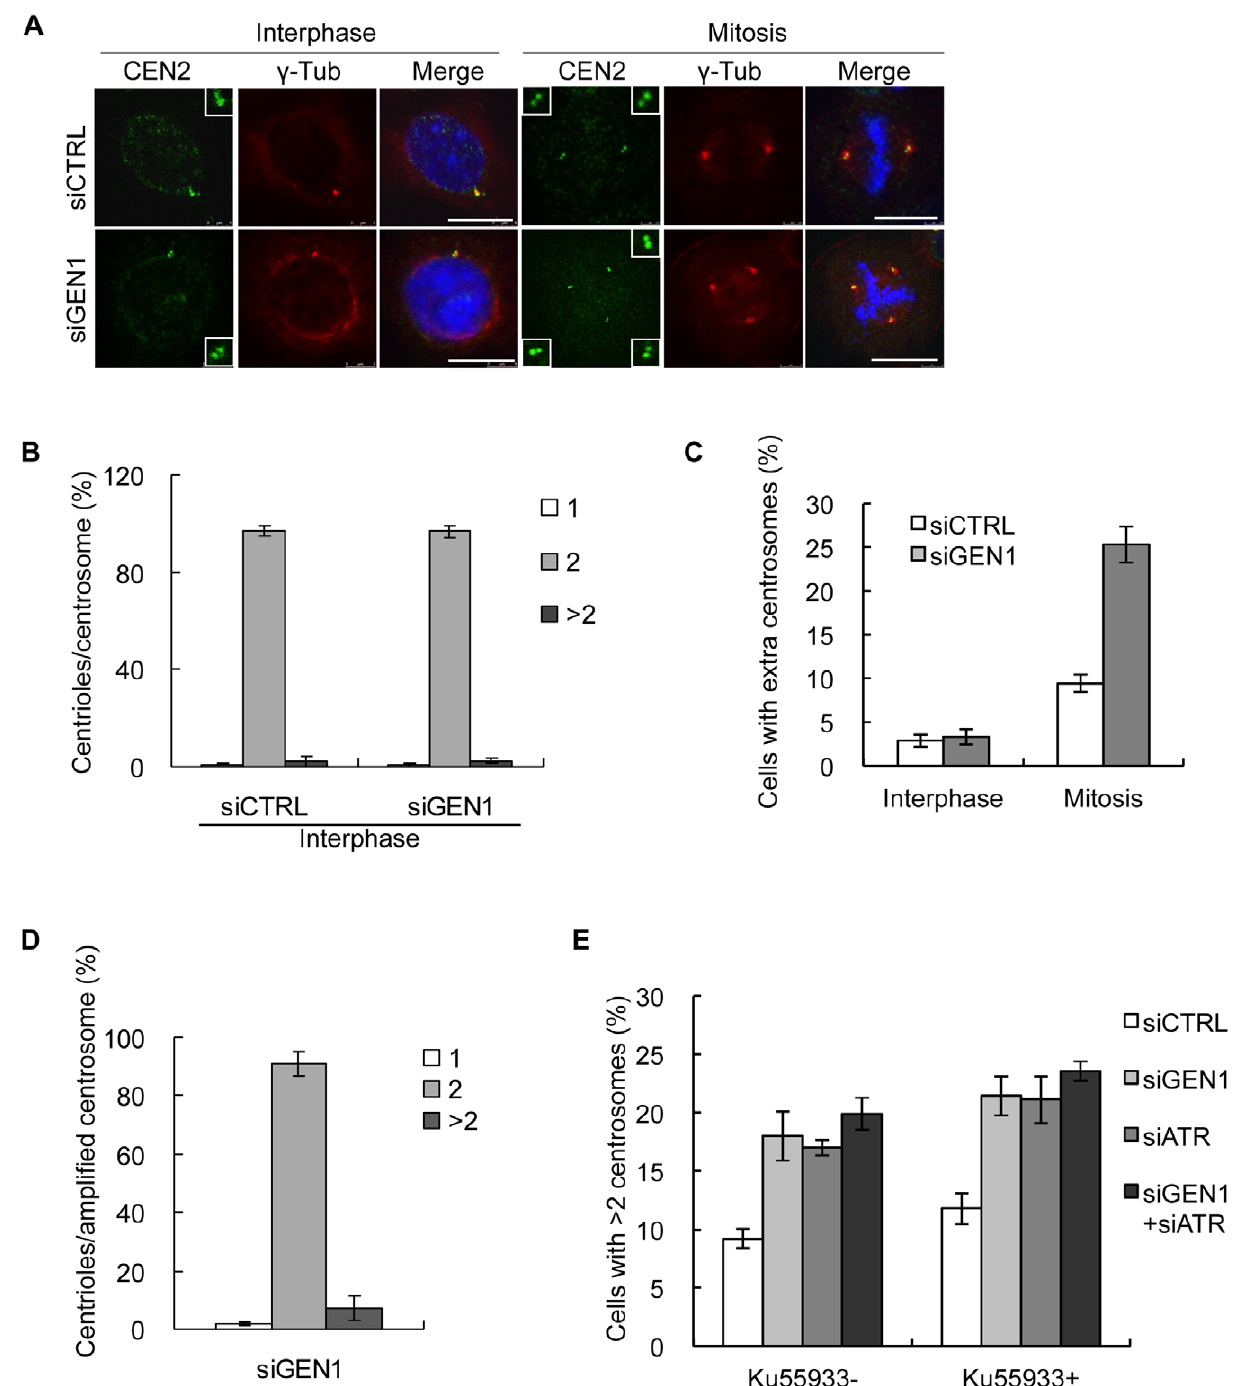
Figure 3. GEN1 depletion results in supernumerary centrosomes in late G2 or mitosis. A. HeLa cells were treated with GEN1 or control (CTRL) siRNA for 48 h, methanol fixed and immunostained with the indicated antibodies. Identification of centrosomes and centrioles was based on immunostaining with c -tubulin and Centrin 2 antibodies, respectively. Scale bar, 10 m m. B. Quantification of centrosomes with 1, 2 or more than 2 centrioles in CTRL or GEN1 depleted interphase cells. Graph represents the mean of three independent experiments. (n=300 centrosomes/condition/ experiment). Error bars indicate S.E.M. C. Quantification of interphase and mitotic cells (Fig. 3A) with extra centrosomes (interphase . 1 centrosome (G1) or . 1 linked centrosome pair (S-G2), mitosis . 2 separated centrosomes). Graph represents the mean of three independent experiments (n=300 cells/condition/experiment). Error bars indicate S.E.M. D. The percent of supernumerary centrosomes with 1, 2 or more than 2 centrioles after GEN1 depletion. Graph represents the mean of three independent experiments. (n=300 centrosomes/condition/experiment). Error bars indicate S.E.M. E. Quantification of mitotic cells with . 2 mitotic spindles 48 h after treatment with CTRL, GEN1 and/or ATR siRNA followed by incubation with or without ATM inhibitor(10 uM Ku55933. Mitotic spindles were visualized by GEN1 (anti-GEN1 (651–892aa) antibody) and c -tubulin immunostaining. Graph represents the mean of three independent experiments. (n=300 cells/condition/experiment). Error bars indicate S.E.M.